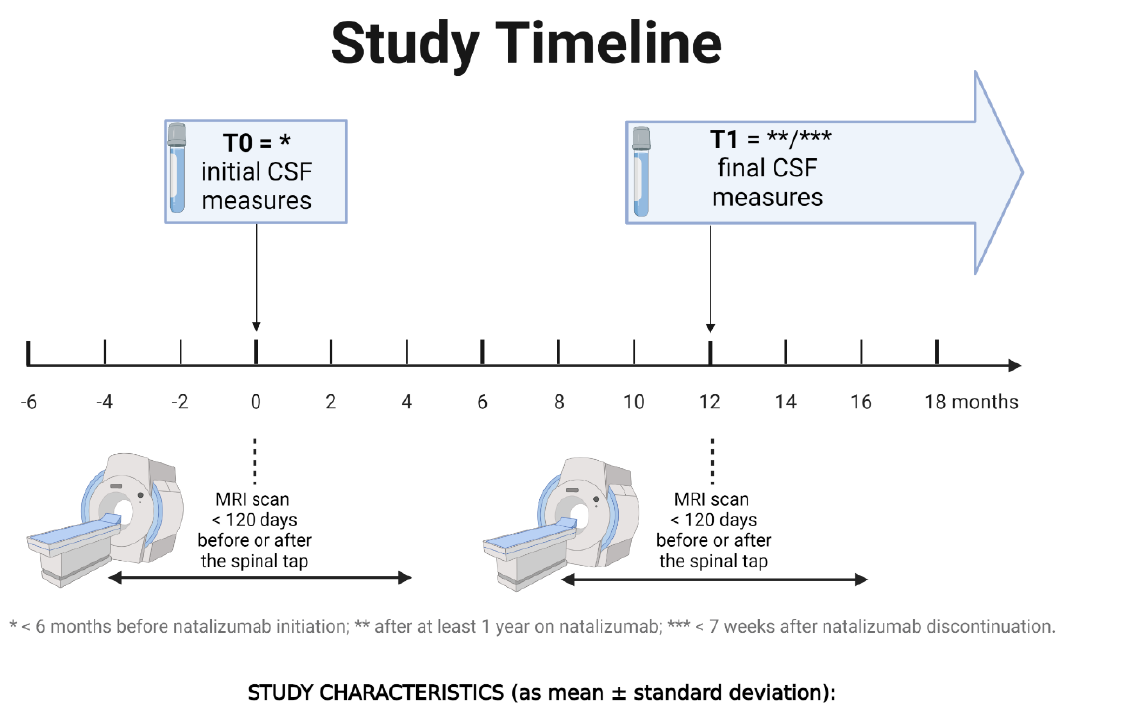
Figure 2. The study timeline. The baseline CSF exam for each patient was less than 6 months before NTZ initiation to ensure that it reflected the actual pre − treatment disease activity. The follow − up CSF exam for each patient was recorded at least 12 months after the initiation of therapy to ensure a sufficient exposition to the NTZ treatment and to ensure sufficient time for changes of biochemical measures. Each of the MRI scans (for the baseline and follow − up timepoint) were performed within 120 days before or after the respective CSF exam to accurately represent the concurrent radiological disease burden. If the NTZ treatment was discontinued in a patient, the final CSF data were recorded a maximum of 7 weeks after the discontinuation of the therapy to rule out a rebound effect.